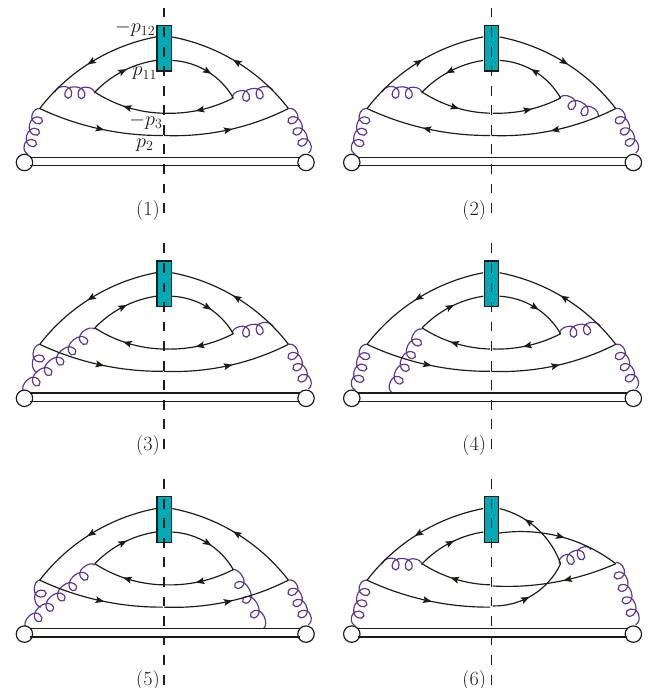
Figure 1 . Six of 49 cut diagrams for the fragmentation functions D